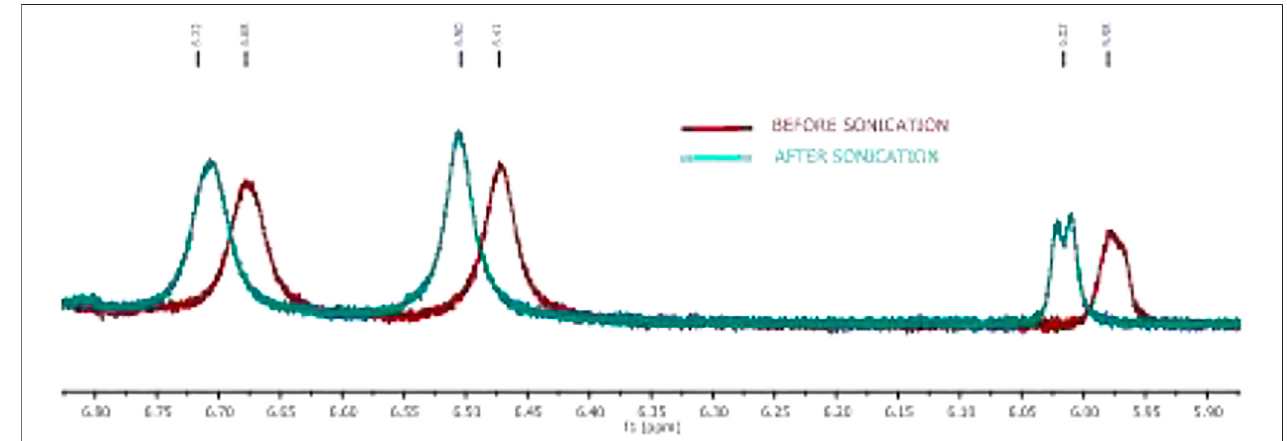
FIGURE 5 | Expanded NMR of the peptide 2c amide N-H region of organogel in toluene-d 8 before (red) and after sonication